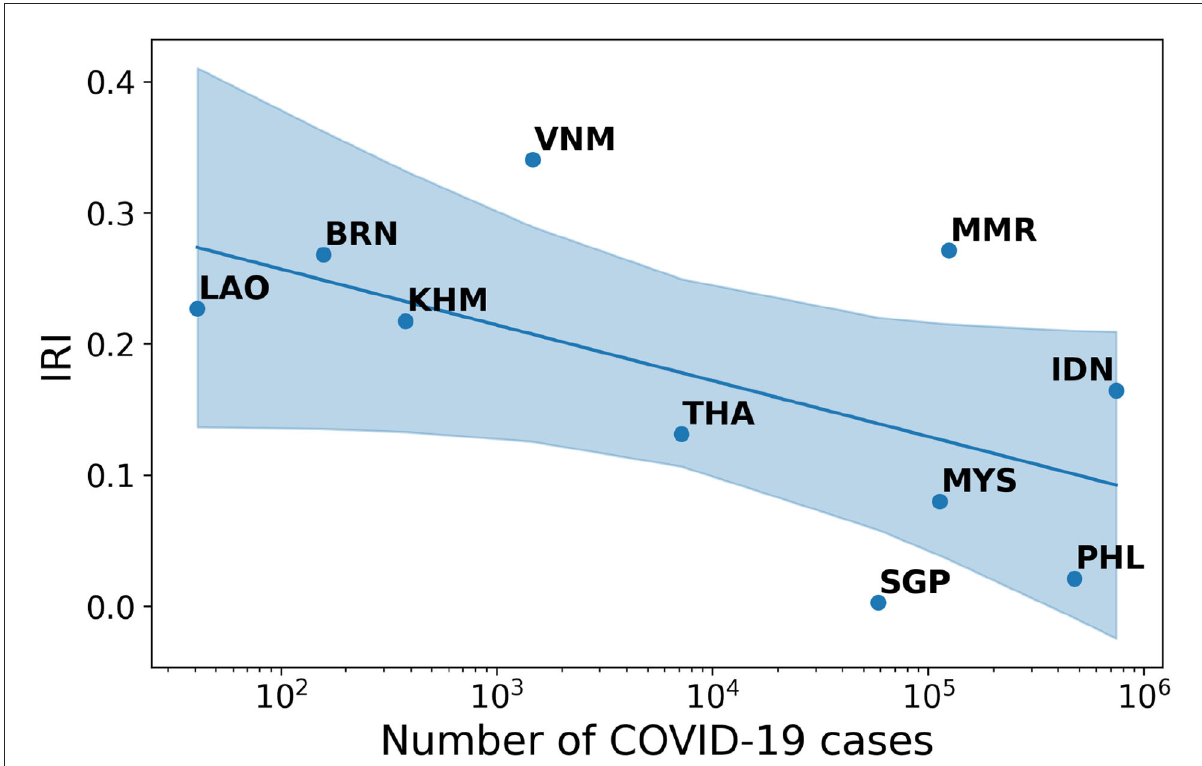
FIGURE2 Correlation between IRI and number of COVID-19 cases in South-Eastern